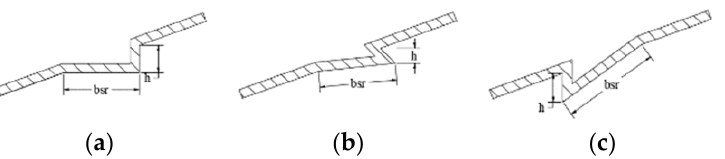
Figure 2. Spray strip profile: ( a ) conventional profile; ( b ) Savitsky profile; ( c ) suggestion profile.